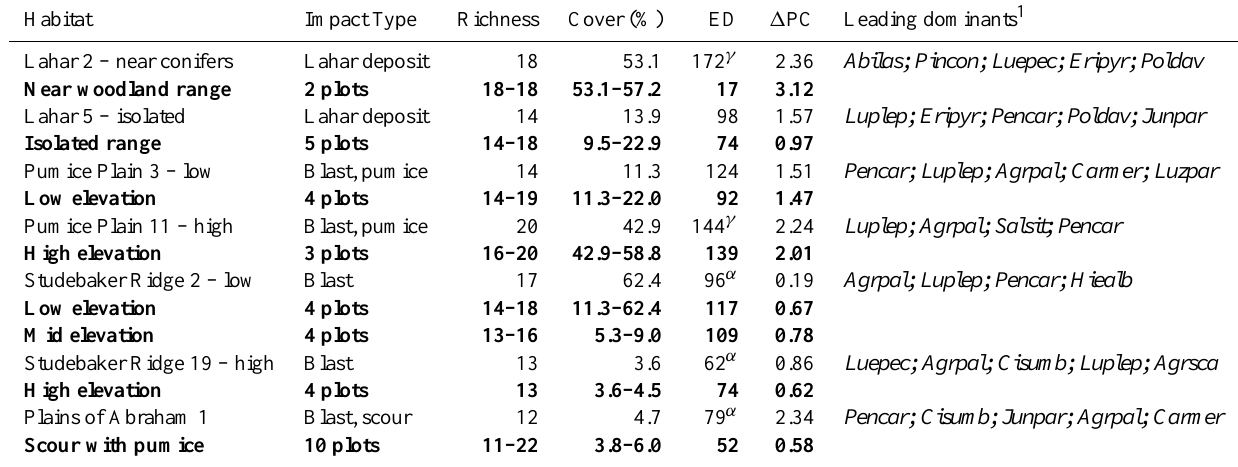
Table 3. Characteristics of sample plots on Mount St. Helens. Richness and cover were the last values recorded. Group richness range is the range of maximum richness. ED and 1 PCA are as described in Table